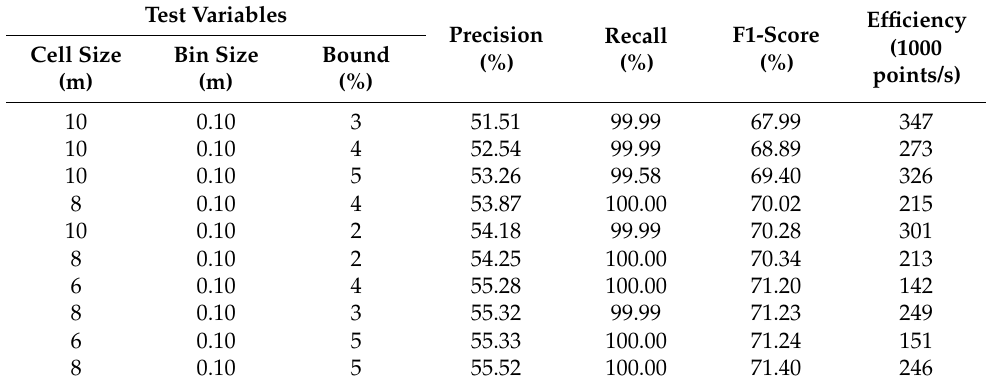
Table 4. Bottom 10 combinations of parameters for the seafloor segmentation with Marco dataset # 1 and